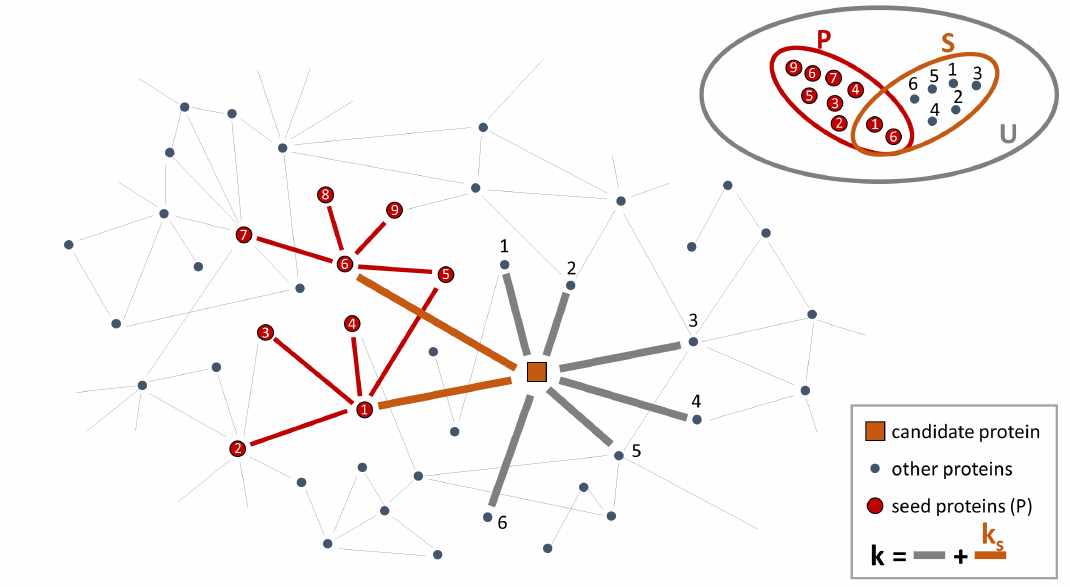
Figure 2. Sketch of step 1 of DIAMOnD. The network corresponds to the interactome where the red balls are the seed proteins, the orange square is the protein to test with k connections (orange and grey thick links) including k s links to seed proteins (orange thick links), the grey balls refer to other proteins in the PPI-network. The sets at top-right correspond to: U is the ensemble of the total number of nodes in the PPI-network, S is the ensemble of the draw of k proteins, including k s seed proteins ( k s = 2 in this example), P is the ensemble of the seed